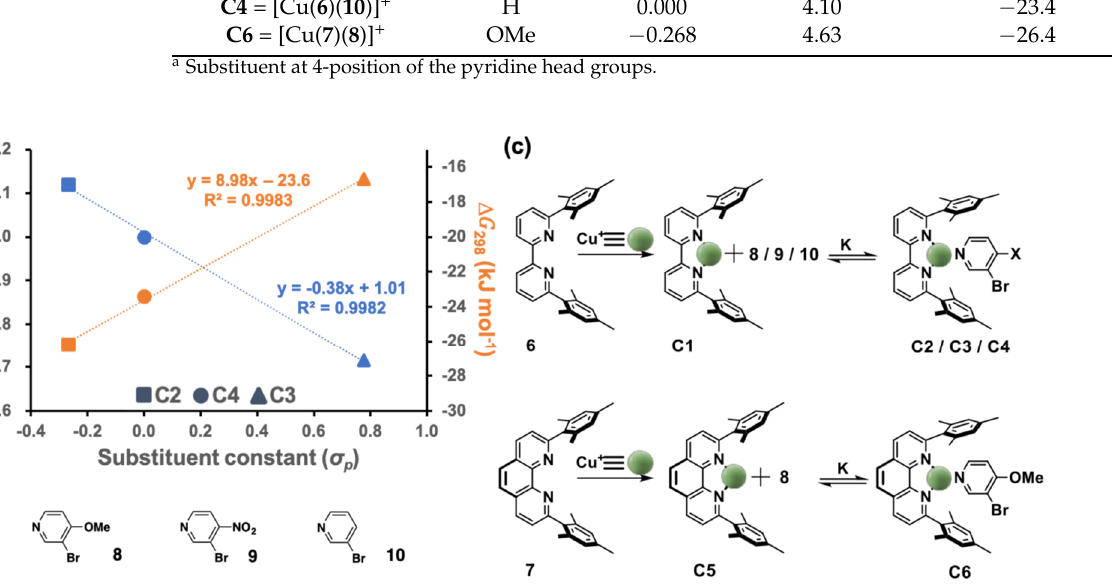
Figure 2. ( a ) The normalized binding constant log K / K H and the Gibbs free energy correlate linearly with the substituent constant. All binding constants were measured in CH 2 Cl 2 . ( b ) Chemical structures of substituted pyridines 8 , 9 and 10 . ( c ) Chemical structures of model complexes C1 – C6 . Table 1. Substituent constants, binding constants and Gibbs free energy of C2 – C4 and C6 , as de- termined from UV–Vis titrations.